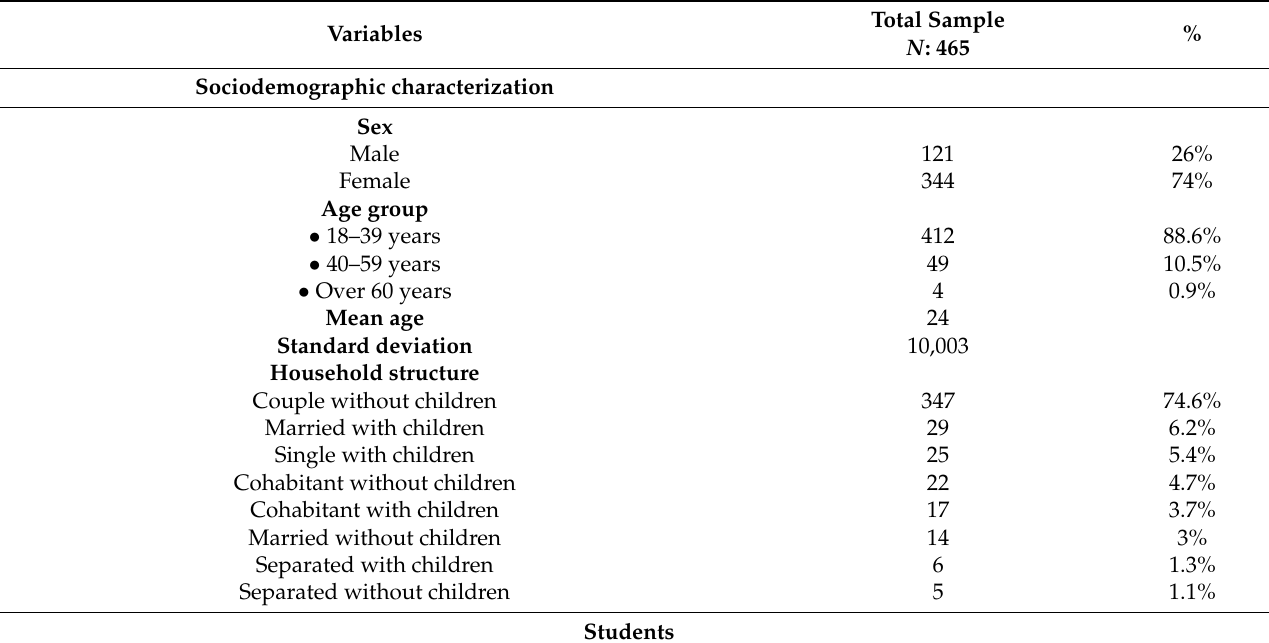
Table 1. Sociodemographic and academic characterization of the study